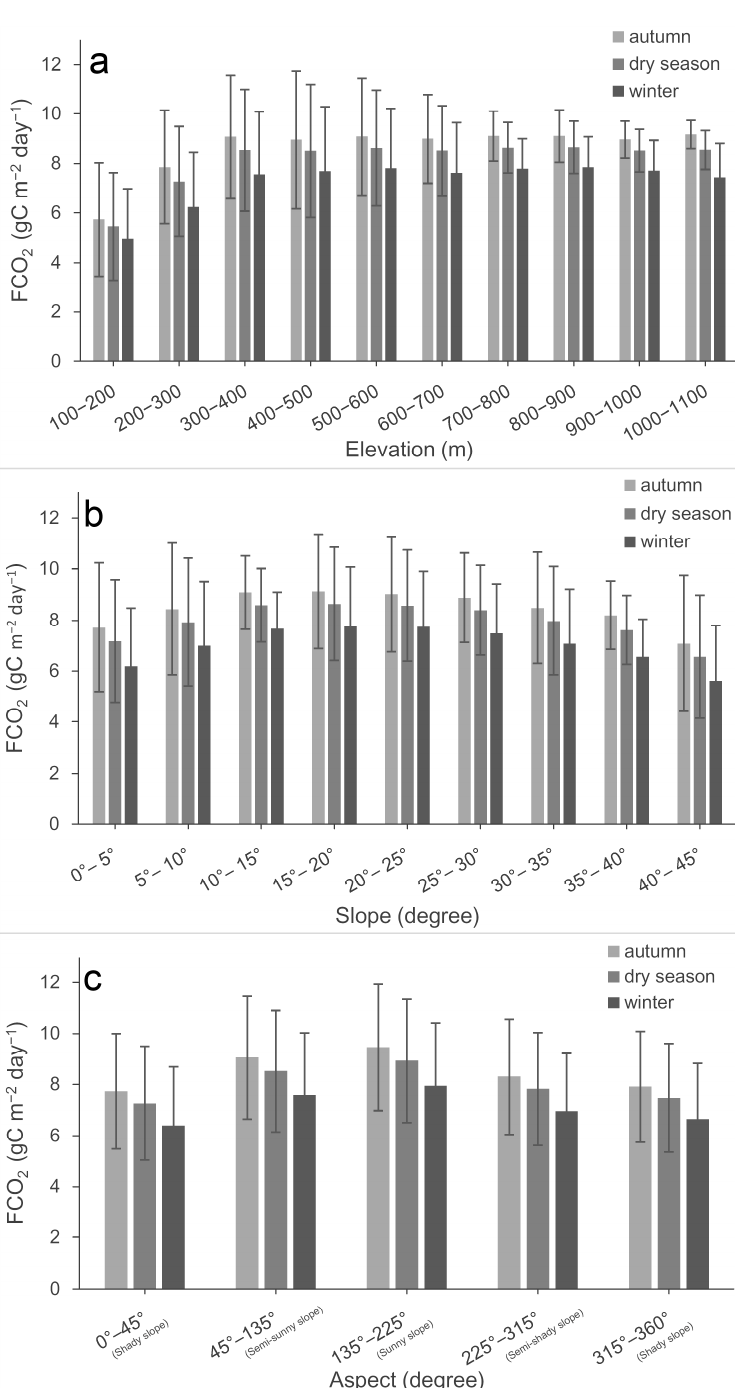
Figure 9. FCO 2 changes are associated with elevation ( a ), slope ( b ), and aspect ( c ). The grey error bars indicate the corresponding standard